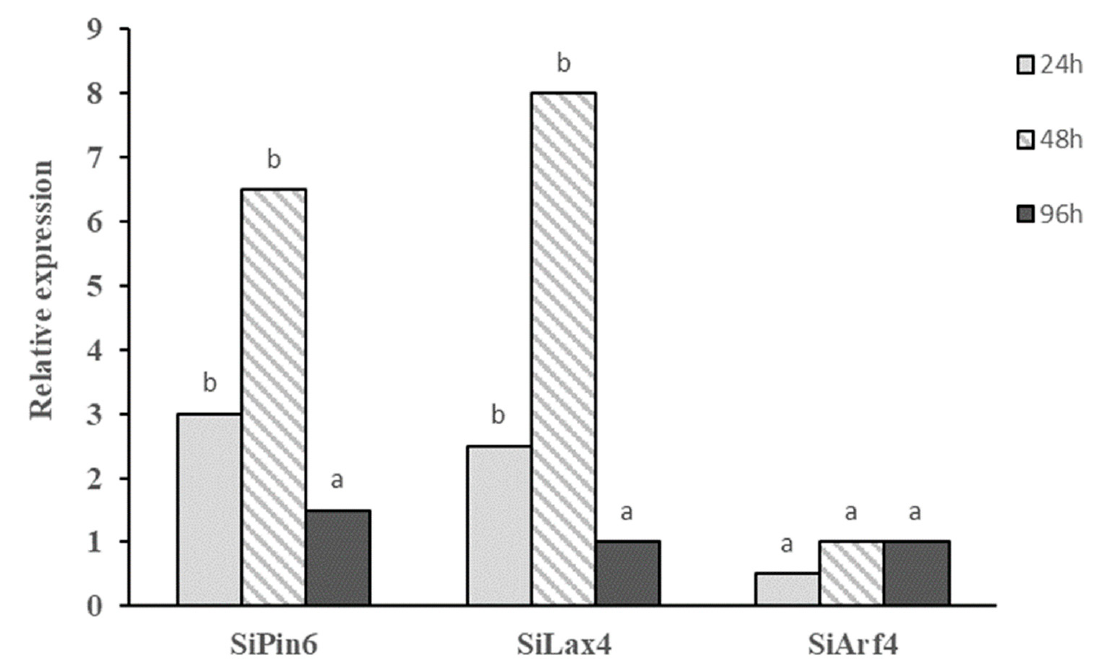
Figure 3. Transcript levels of auxin-related genes ( SiPin6 , Silax4 , and SiArf4 ) in tomato plants (cv. Belladonna) after treatment with Bacillus subtilis MBI 600. Expression levels were analyzed by qRT-PCR at 24, 48, and 96 h post-application compared to untreated plants. The cDNA samples were normalized using the endogenous cox gene. Different letters on the columns indicate significant differences at the three time points according to Tukey’s test at p = 0.05.